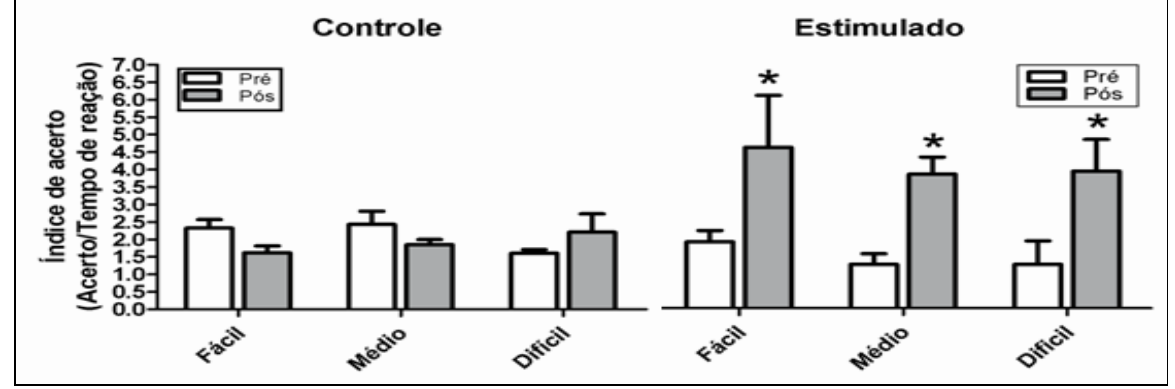
Figura 5. Índice de acerto (Acerto/Tempo de reação). A figura ilustra a divisão entre o índice de acerto que é obtido pelo tempo de reação nos grupos experimental e controle no momento pré e pós-estimulação cortical. (*) Indica a diferença entre o grupo experimental (estimulado) no momento pré e pós onde p<0.05. Verifica-se na figura 6 o total do índice de acertos pelo tempo de reação do grupo controle (esquerda do gráfico) no momento pré, do grupo controle quando comparado com o momento pós, não se obteve